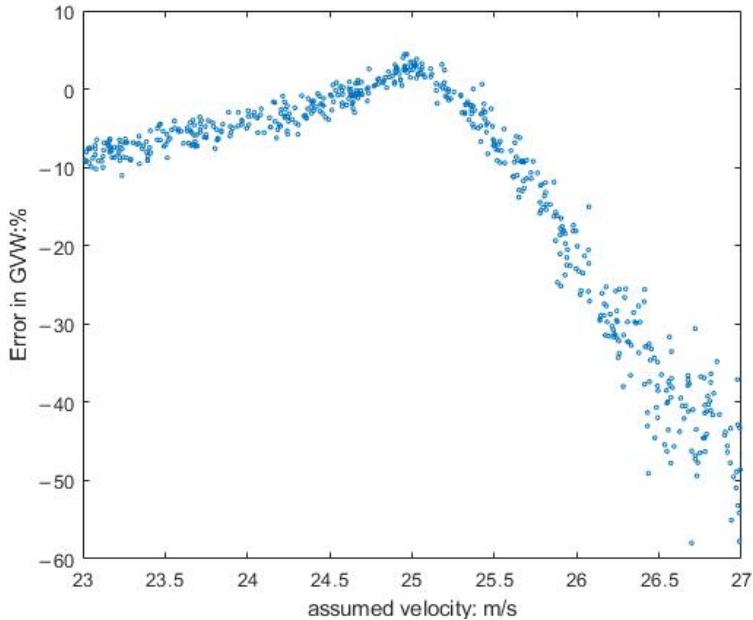
Figure 5. Error in the inferred GVW due to inaccurate estimation of vehicle